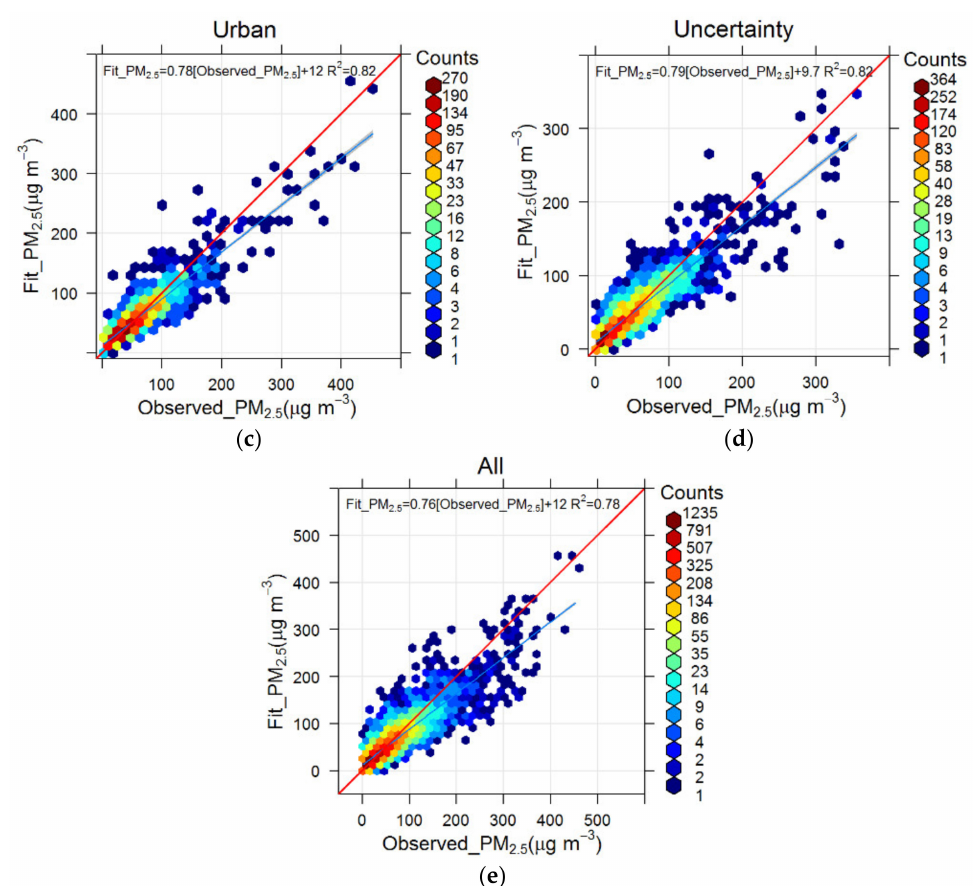
Figure 3. Cross validation of the predicted vs. observed PM 2.5 concentrations for di ff erent aerosol types. ( a ), ( b ), ( c ), ( d ), and ( e ) show the dust, smoke, urban, uncertainty, and all, respectively. Table 5. Parameters of cross validation for the model in Sichuan–Chongqing (SC), Pearl River